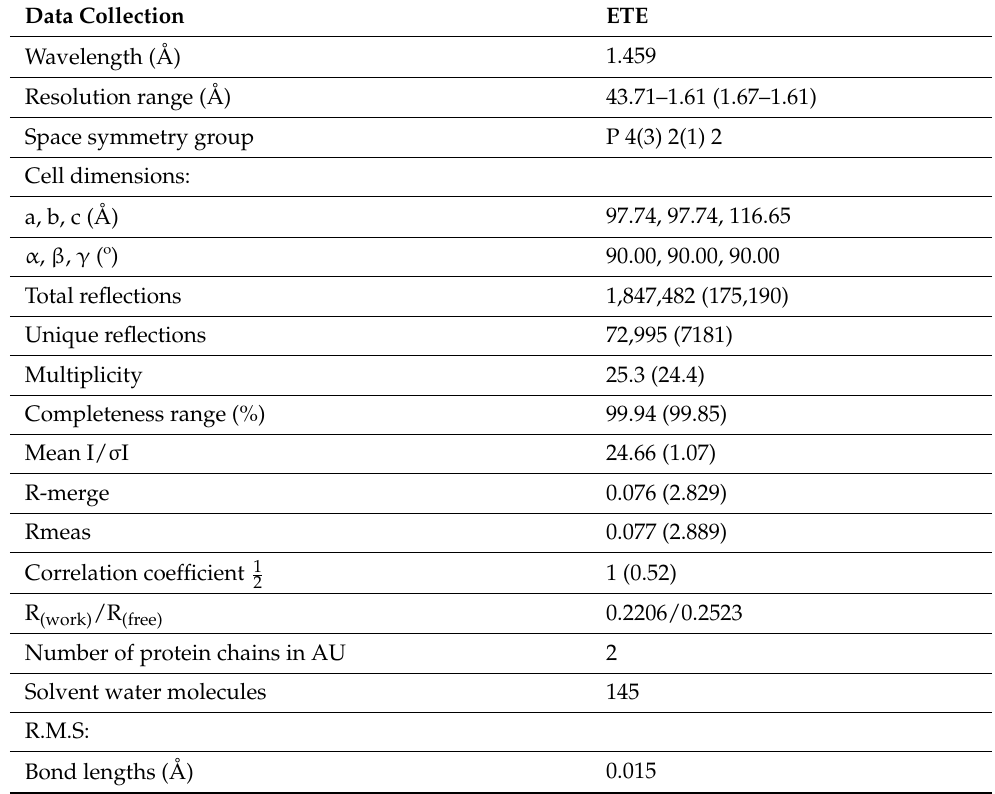
Table 1. Crystallographic data processing and refinement statistics of ETE PDB structure